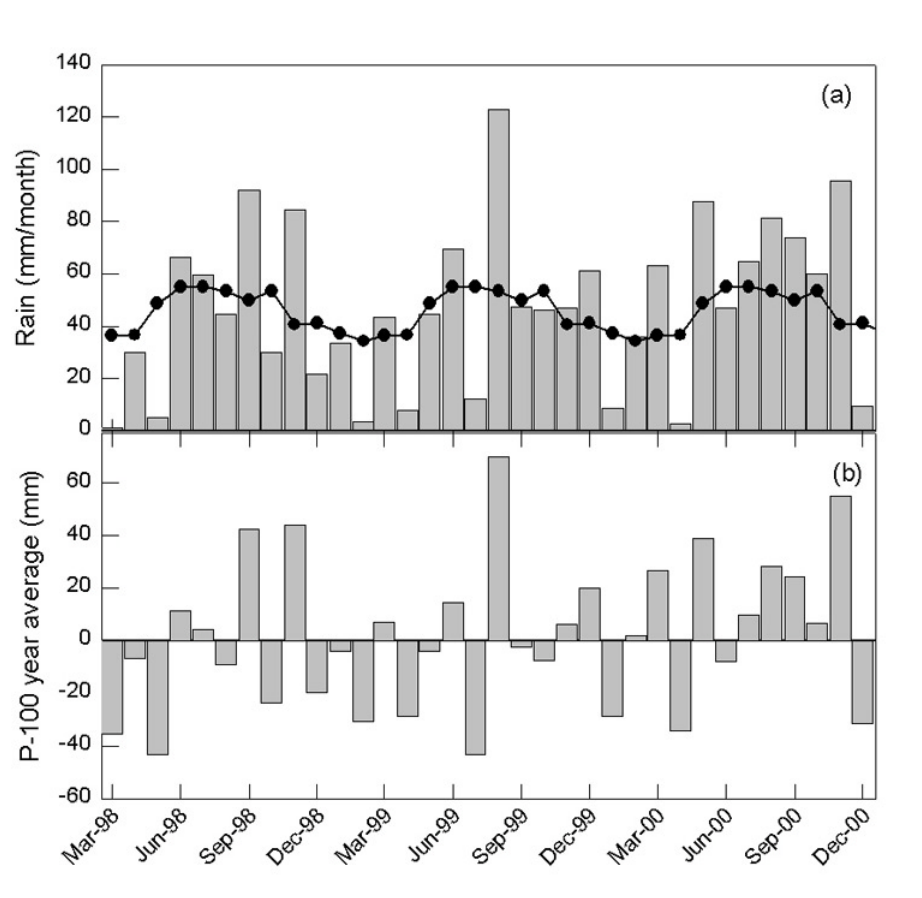
FIGURE 1. Monthly rainfall (P; vertical bars) at the effluent irrigated site, average 100-year monthly rainfall ( (cid:1) ), and the difference between monthly rainfall and the 100-year average rainfall from March 1998 to December 2000 (100-year average from the SILO Point patched